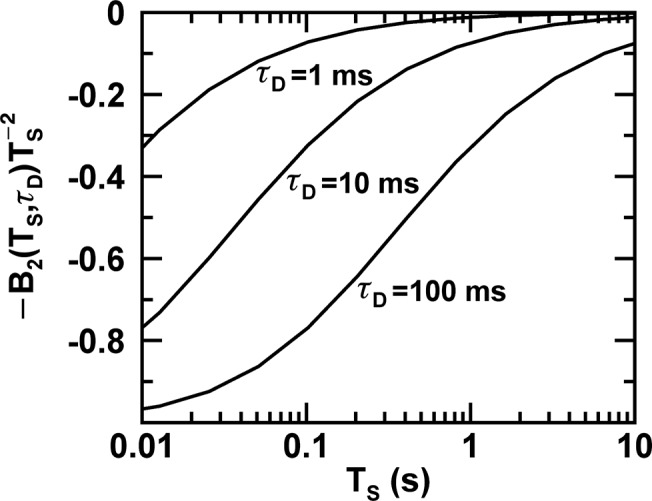
Relative bias in the Q-value introduced by diffusion.Correlations in the photon counts introduced by the diffusion time τ
D give rise to a relative bias in the Q-estimator that depends on the segment period T
S. The relative bias for diffusion times of 1 ms, 10 ms, and 100 ms is shown.